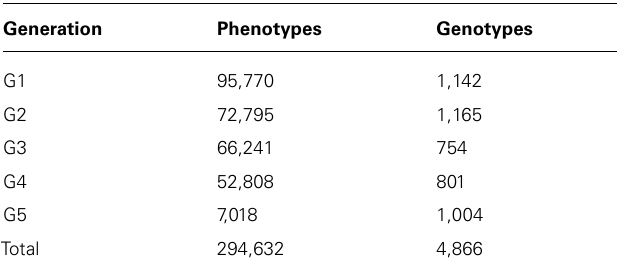
Table 1 | Number of animals with phenotypes and genotypes in each generation.